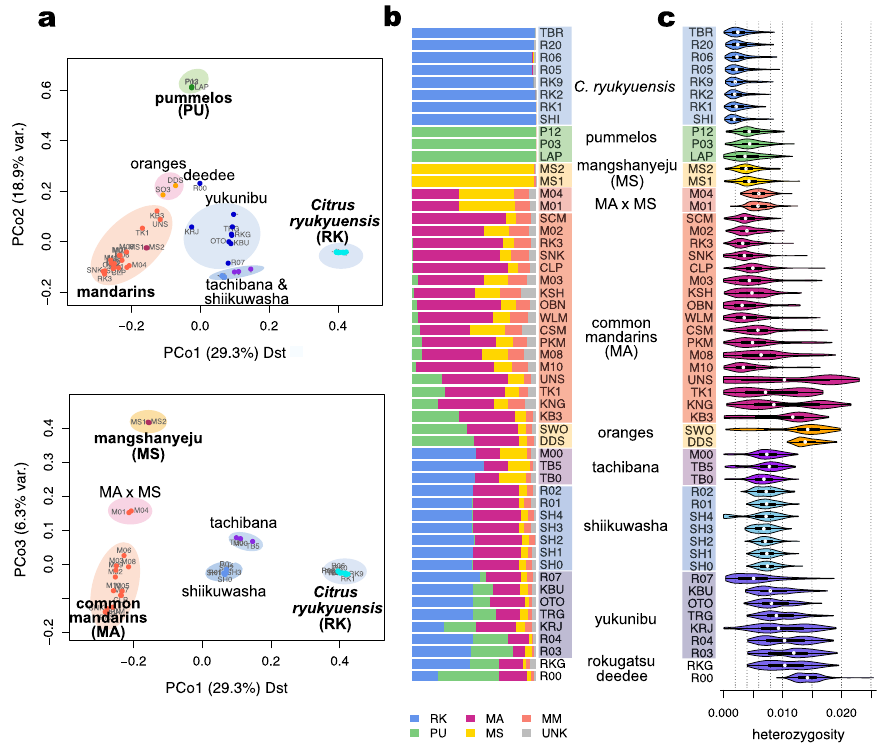
Fig. 1 Population structure, genetic admixture, and heterozygosity of east Asian citrus. a Multidimensional scaling (MDS) plot of 51 citrus accessions. Projection onto the fi rst two principal coordinates (upper panel) shows C. ryukyuensis as a distinct population from tachibana, shiikuwasha, and other Ryukyuan hybrids (yukunibu and deedee). The third principal coordinate (lower panel) separates the two Mangshan wild mandarins (MS) from other mandarins. It also separates tachibana from shiikuwasha. For easier visualization, accessions with signi fi cant pummelo ancestry (pummelos, oranges, some mandarins, yukunibus) are not shown in the lower panel. See Supplementary Data 1 and 3 for accession code and names. b Four-way admixture plot of 53 citrus accessions based on local ancestry inference. PU = pummelo ( C. maxima ), RK = C. ryukyuensis , MS = mangshanyeju, MA = common mandarin, MM = generic C. reticulata without subspecies assignment (MS vs MA), UNK = unknown. Note that tachibana has more MS alleles than shiikuwasha and other Ryukyuan hybrids. Some wild mandarins (M01, M04) are hybrids with nearly equal contribution from the two subspecies of MS and MA. Common mandarins display varying degree of MS admixture. c Heterozygosity distribution violin plot for the same accessions as in b ), for non-overlapping windows of 500,000 callable sites. C. ryukyuensis shows the lowest heterozygosity compared to tachibana, shiikuwasha and other hybrid types as well as accessions from C. reticulata and C. maxima . Median and quartiles are denoted by the white dot and black bar limits respectively, and whiskers are 1.5× inter-quartile range. Source data are provided as a Source Data fi